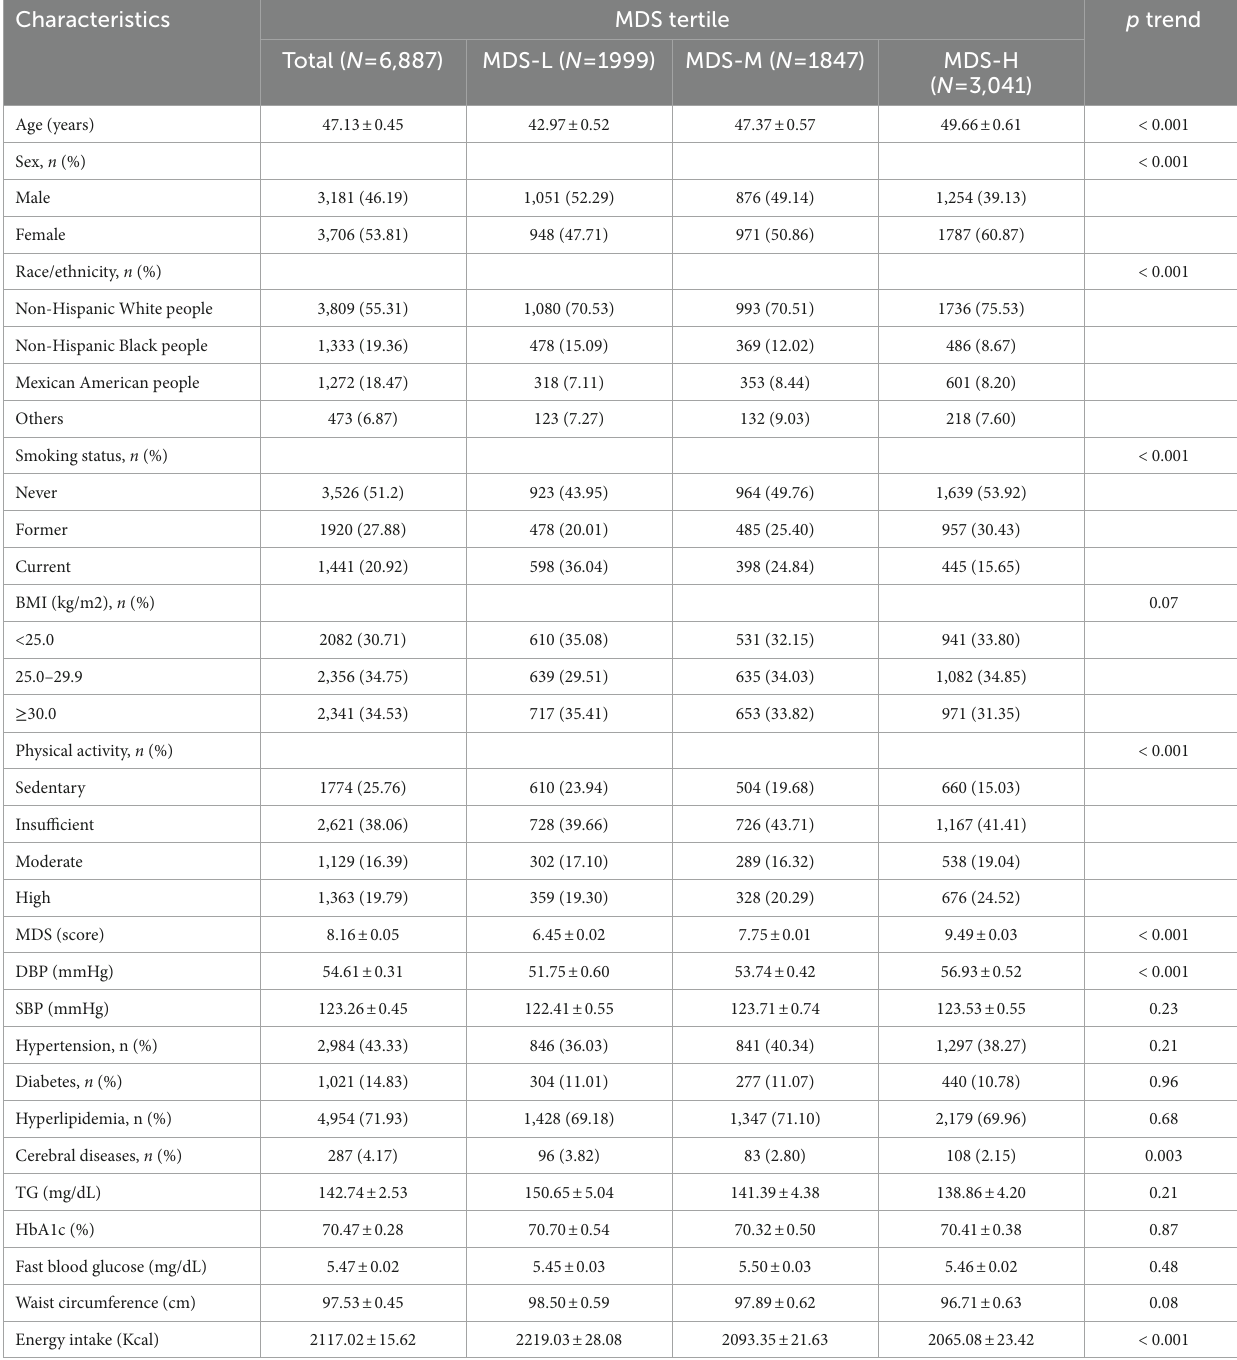
Data are presented as weighted means ± SEs for continuous variables and unweighted numbers (weighted percentages) for categorical variables. MDS-L, Low MIND score, the MIND diet score < 7.5; MDS-M, Medium MIND score, the MIND diet score ≥ 8 and < 8.5; MDS -H, High MIND score, the MIND diet score ≥